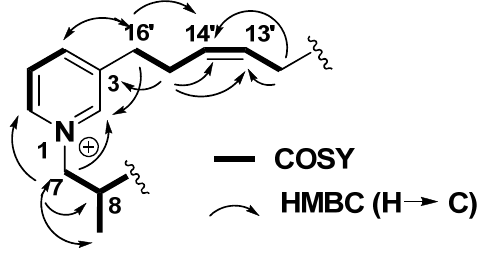
Figure 2. Key COSY and HMBC correlations of njaoaminium B ( 2